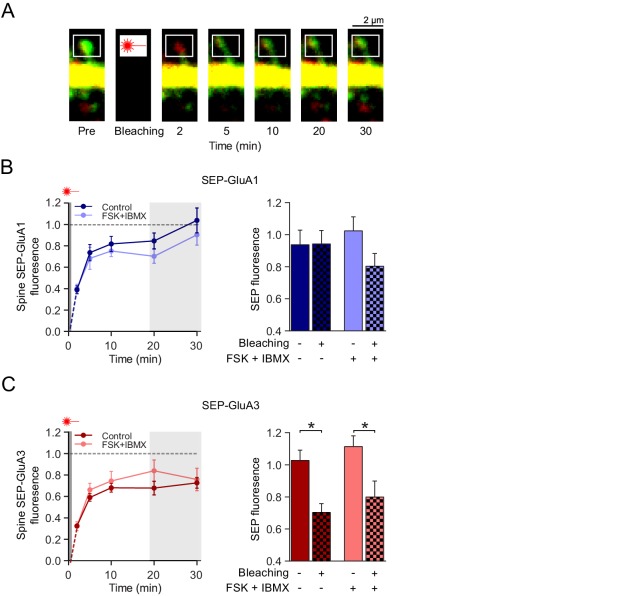
cAMP does not affect GluA2/3 mobility or trafficking to synapses.(A) Example image of a FRAP experiment: a spine from a CA1 neuron transfected with SEP-GluA3 + tdTomato obtained with two-photon microscopy immediately before, and 2, 5, 10, 20 and 30 min after photobleaching of the spine. (B) Left: Quantification of FRAP dynamics of spines transfected with SEP-GluA1 + tdTomato in the absence (dark blue; n=8) and the presence (light blue; n=6) of forskolin and IBMX. Right: Average fluorescence at time-points 20 min and 30 min after photobleaching of bleached spines (Ctrl: n=7, FSK/IBMX: n=8) in comparison to non-bleached neighboring spines (Ctrl: n=6, FSK/IBMX: n=6) in absence (ANOVA, p>0.9) or presence (ANOVA, p=0.3) of forskolin (see Figure 4—figure supplement 1). (C) Left: Quantification of FRAP dynamics of spines transfected with SEP-GluA3 + tdTomato in the absence (dark red; n=7) and the presence (light red; n=8) of forskolin and IBMX. Right: Average fluorescence at time-points 20 min and 30 min after photobleaching of bleached spines in comparison to unbleached neighboring spines (Ctrl: n=5, FSK/IBMX: n=5) in the absence (ANOVA, p=0.04) or presence (ANOVA, p=0.04) of forskolin (see Figure 4—figure supplement 1). Error bars indicate SEM, * indicates p<0.05.